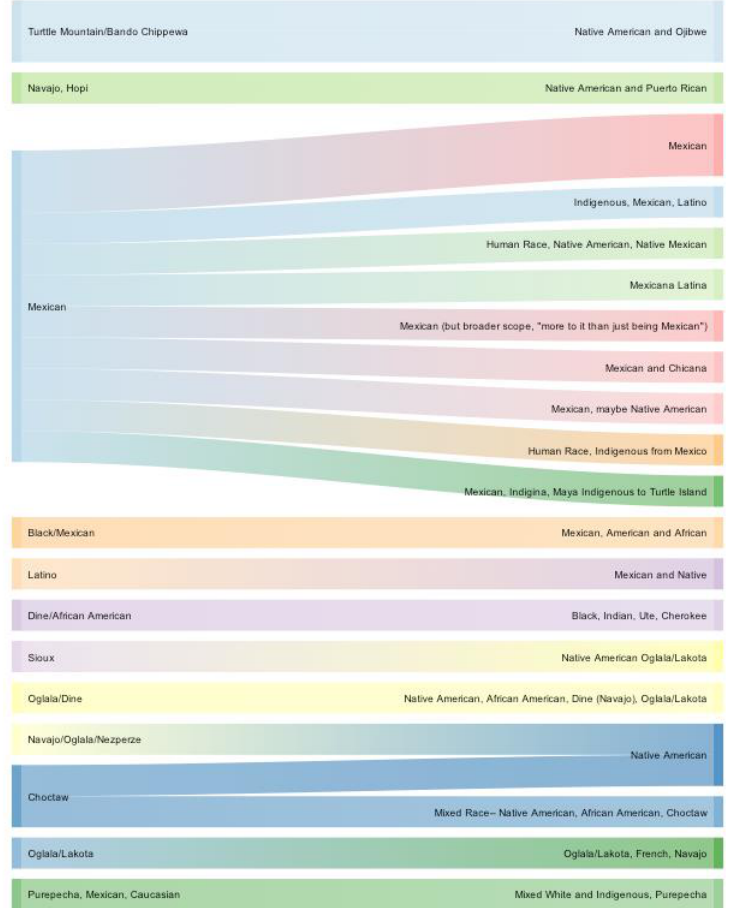
Figure 2. Changes in Tribal and Racial/Ethnic Identity. This is a data visualization graphic depicting changes in tribal and racial/ethnic identity from the baseline demographic survey to the post-intervention interviews. The categories on the left are the data derived from the baseline demographic survey. The categories on the right are the post-intervention identity descriptions gathered in the interviews. The thicker lines depict multiple participants and displays the shifting racial/ethnic and tribal identification of participants pre- and post-intervention.